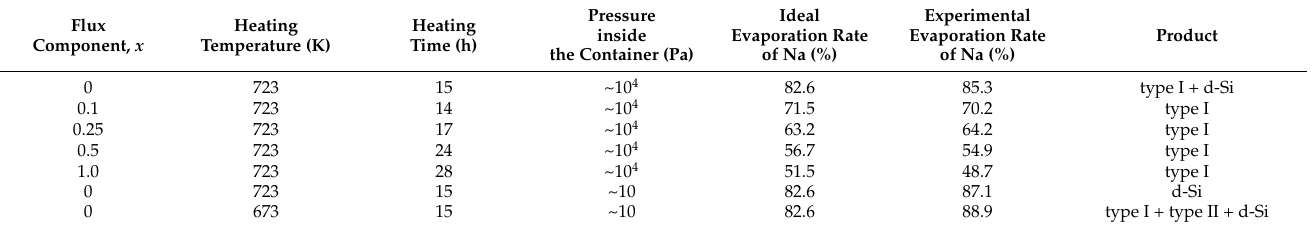
Table 1. Experimental conditions, ideal and experimental Na evaporation rates, and reaction products obtained under these